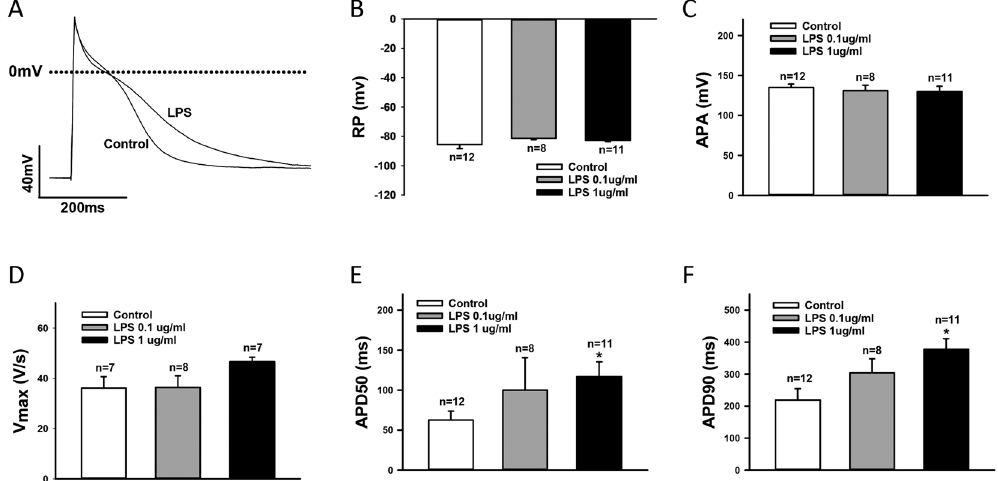
Figure 5. LPS-treatment prolonged APD. ( A ) Representative traces of action potentials (AP) in control and LPS-treated hiPSC-CMs. ( B ) Mean values of resting potentials (RP). ( C ) Mean values of action potential amplitude (APA). ( D ) Mean values of maximal upstroke velocity of AP (Vmax). ( E ) Mean values of APD at 50% repolarization (APD50). ( F ) Mean values of APD at 90% repolarization (APD90).Values given are mean ± SEM. n, number of cells. * p < 0.05.